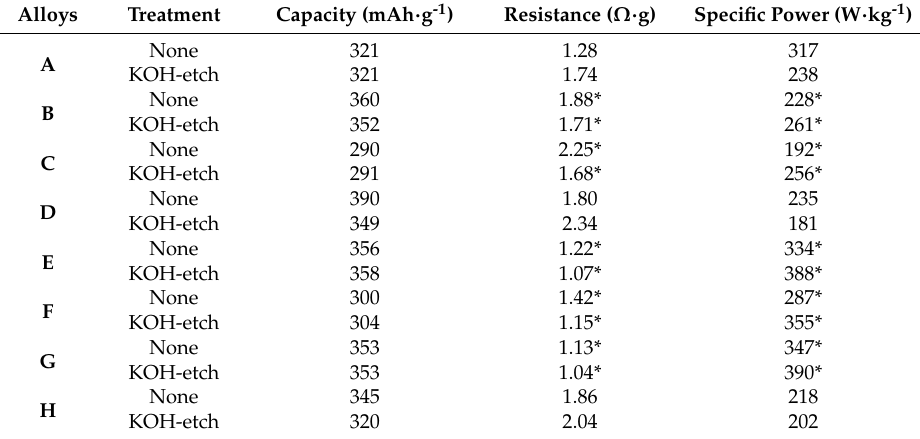
Note: * The reduced R from the KOH-etch treatment.